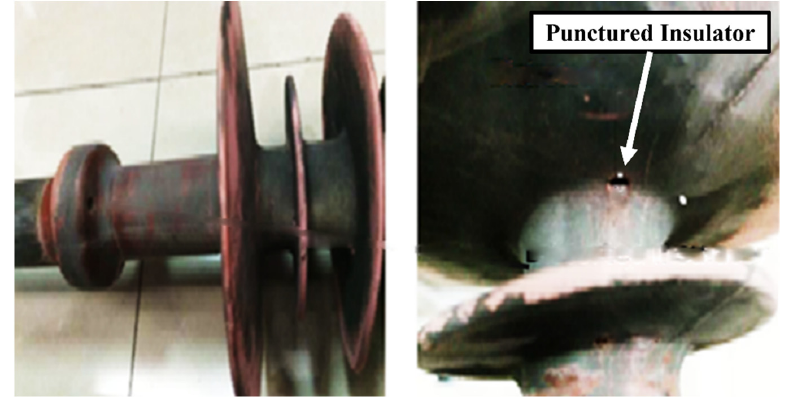
Figure 18. Punctured insulator [67].